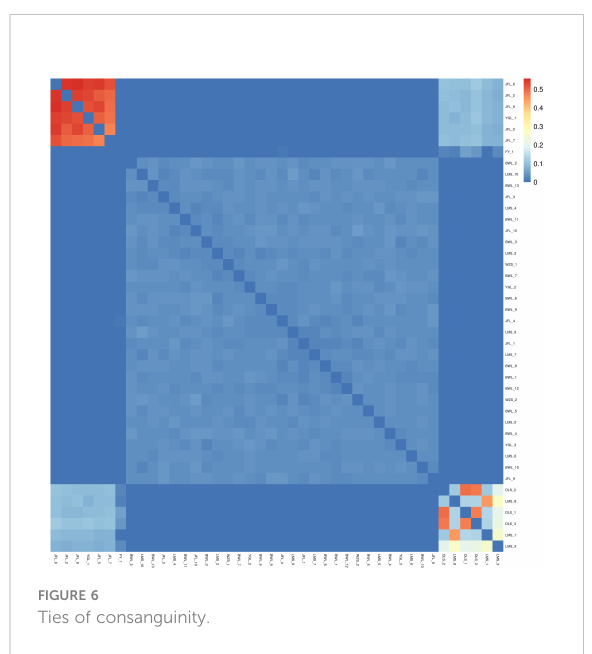
FIGURE 6 Ties of